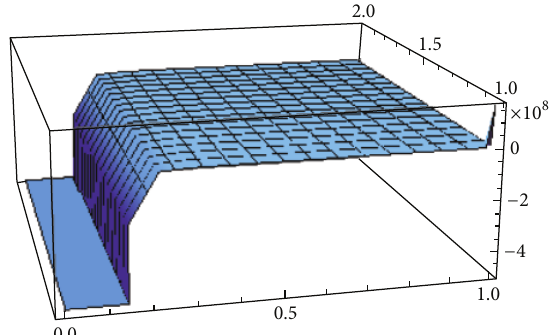
Figure 2: The figure is plotted for (𝑟 8 ⋆ /𝑅 6 )(4𝐴𝐶 − 𝐵 2 )𝑟 AdS 5 black hole outside the horizon for which 0 ≤ 𝑢 < 1 and 1 < 𝑛 ≤ 2